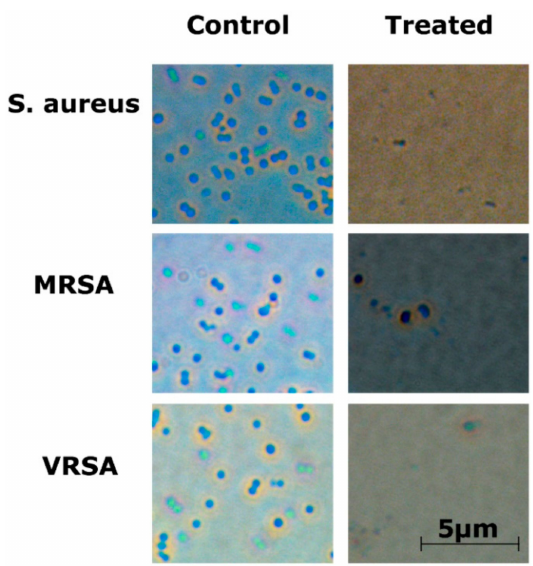
Figure 7. Optical microscopy image for RU-S4 treatment against S. aureus (NCTC 8511), MRSA (ST239: SCCmecIIIA), VRSA (CCM 1767), and untreated cells. No morphological changes were seen in untreated cells whereas the treated bacterial cells were ruptured and almost no visible structured cells can be seen. Scale bar is 5 µ m.